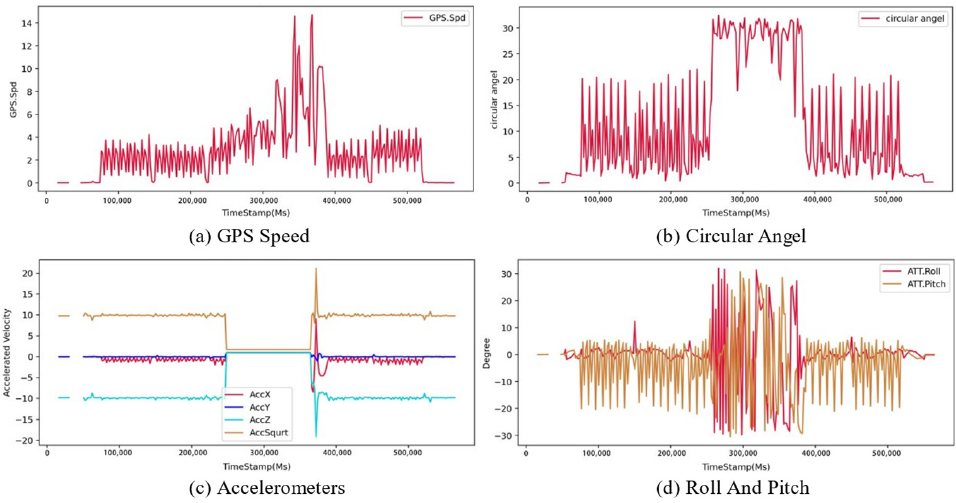
Figure 12. State change of drone with accelerometer failure.